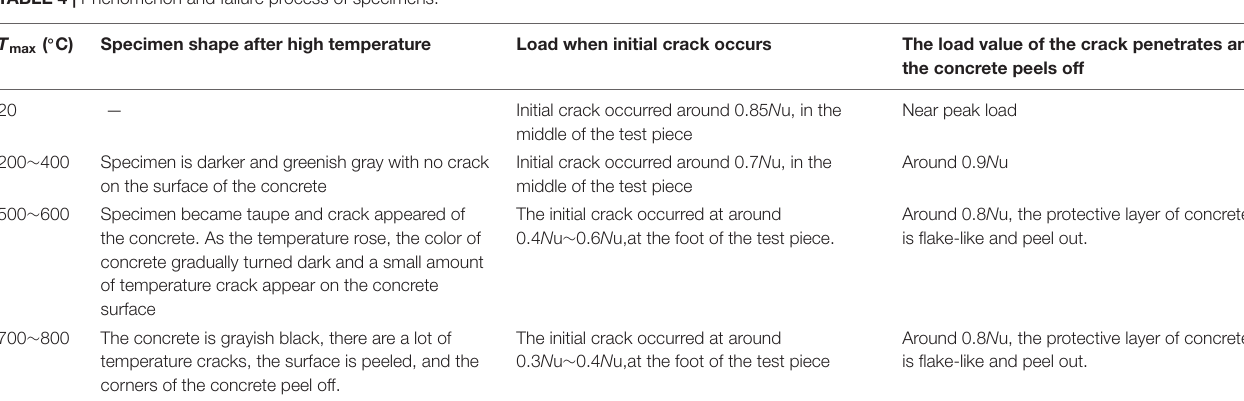
TABLE 4 | Phenomenon and failure process of